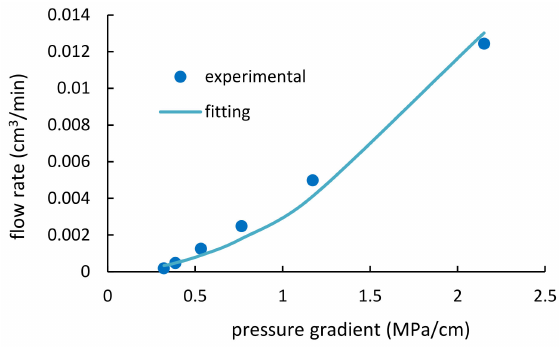
Figure 18. Displacement curve of Jiyang shale oil